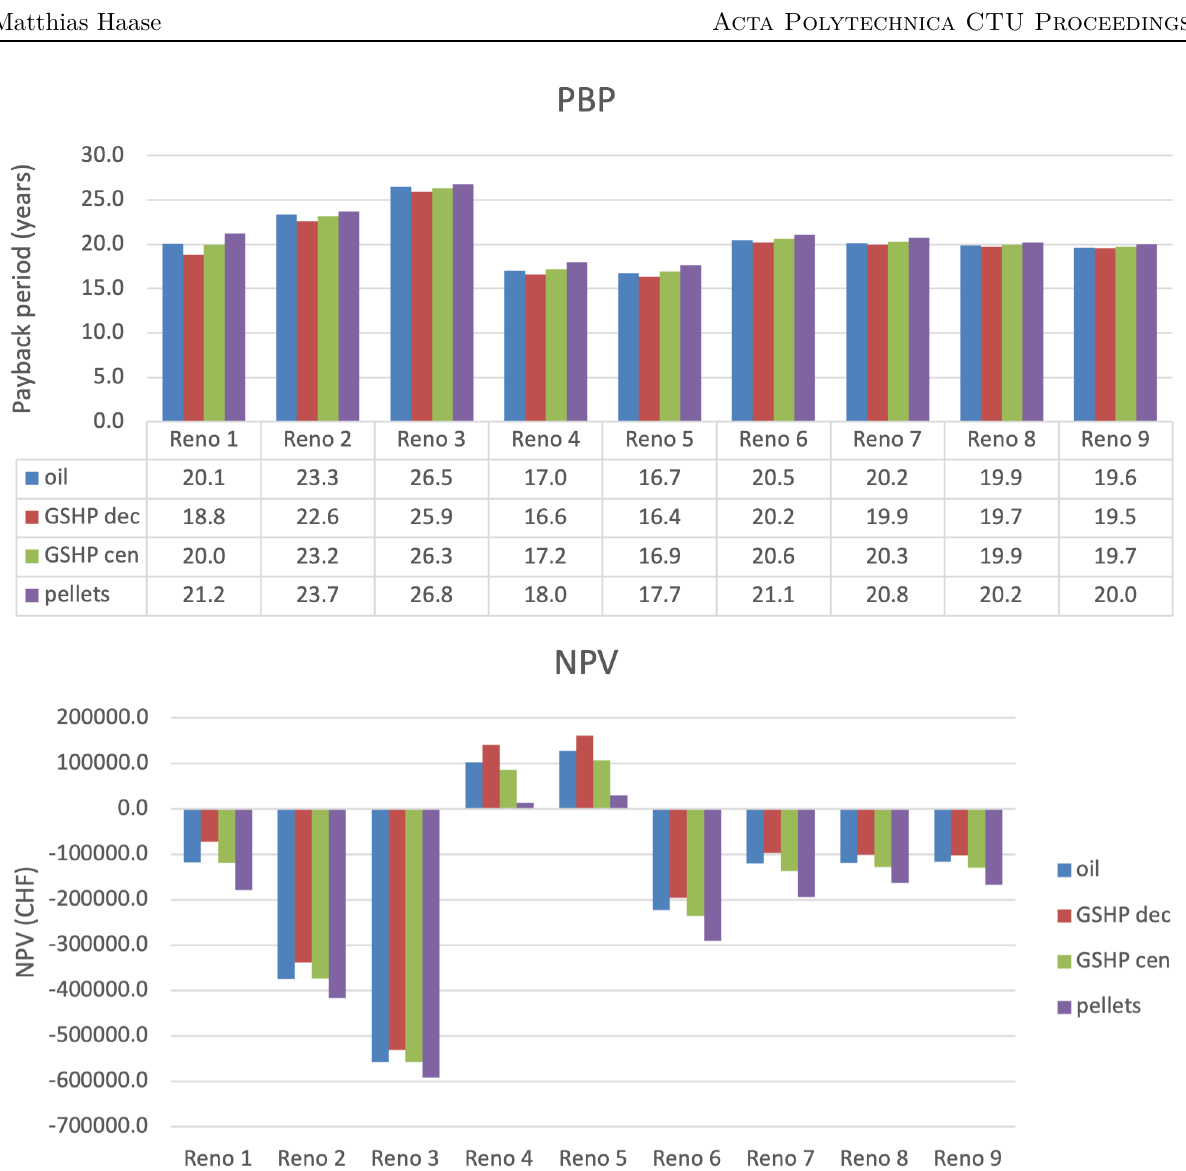
Figure 2. Economic evaluation of the renovation options (PBP and